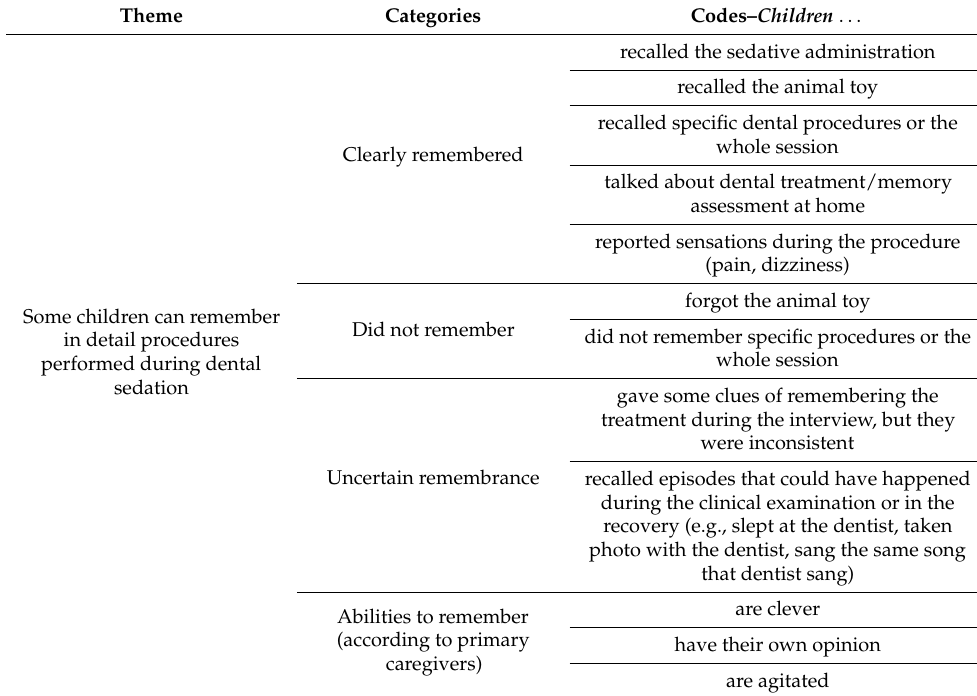
Table 3. Content analysis outcomes related to children’s